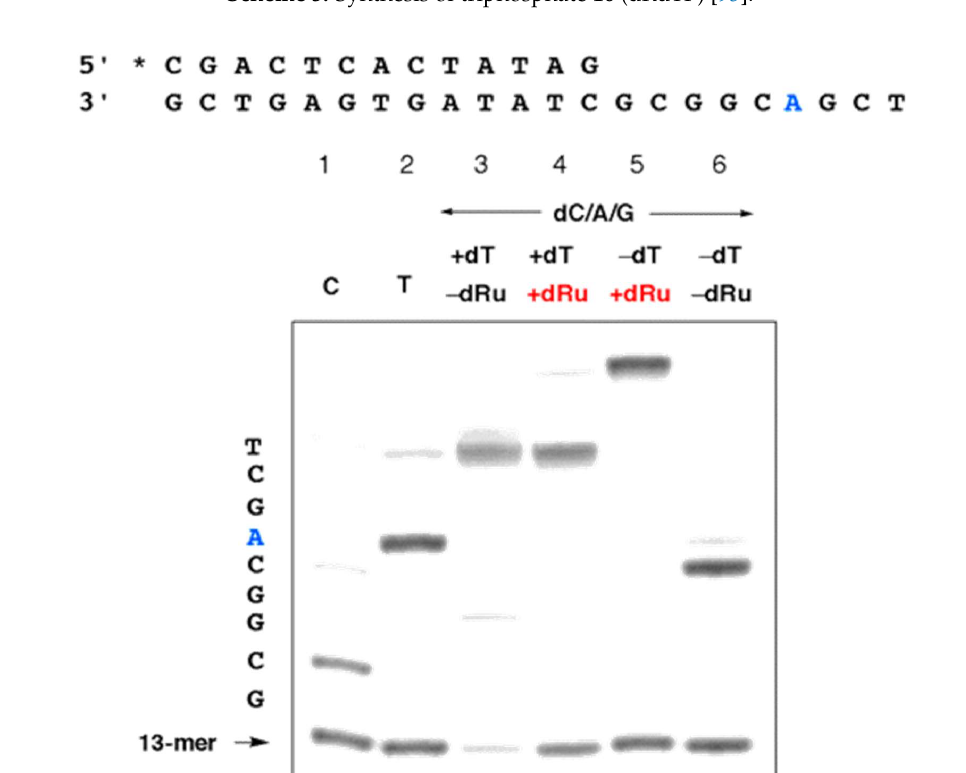
Figure 7. Enzymatic incorporation of dRuTP. Primer extension experiments using the Klenow fragment of DNA polymerase I resolved on a 20% PAGE. Lanes 1 and 2: control reactions missing one natural triphosphate (dCTP or TTP); lane 3: control reaction with all four natural dNTPs; lane 4: four natural dNTPs and dRuTP; lane 5: dRuTP used instead of TTP; lane 6: control reactions without TTP and dRuTP. Figure taken from [95] with